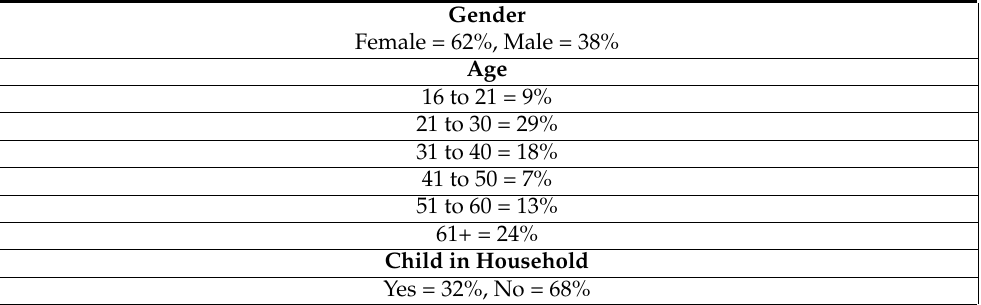
Table 4. Greenspace respondent profile data. Individual respondents (n = 55).